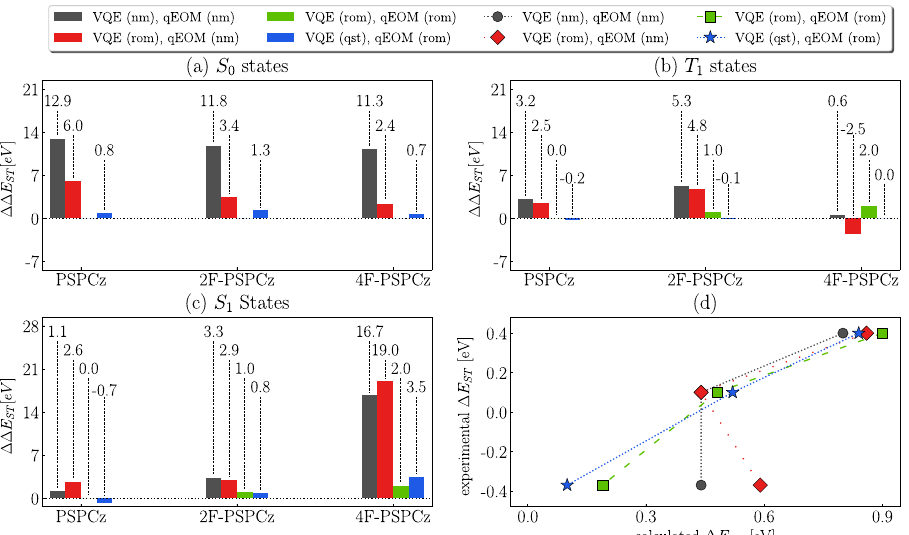
Fig. 4 Electronic energies, in milliHartrees (mHa), of ground and excited states of PSPCz molecules, and correlations of predicted and experimental energy gaps, in eV. Energies of the a S 0 , b T 1 , and c S 1 states predicted by VQE and qEOM-VQE on ibmq_boeblingen in comparison to exact diagonalization. d Correlations between Δ E ST for the PSPCz molecules from spectral experiments and qEOM-VQE calculations with the R y Ansatz using the 6-31G(d) basis set. (nm non-mitigated, rom readout error mitigation, qst quantum state